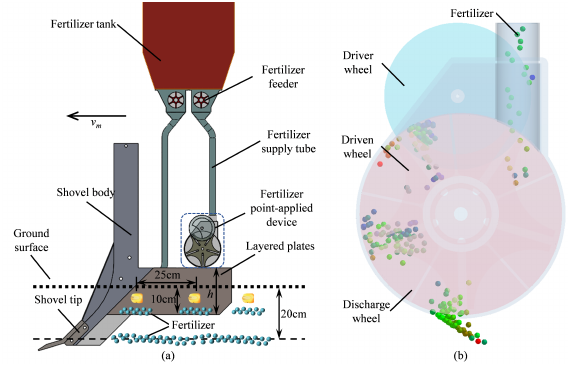
Fig. 1. Model of fertilizer point-applied device: (a) actual model; (b) simulation model based on